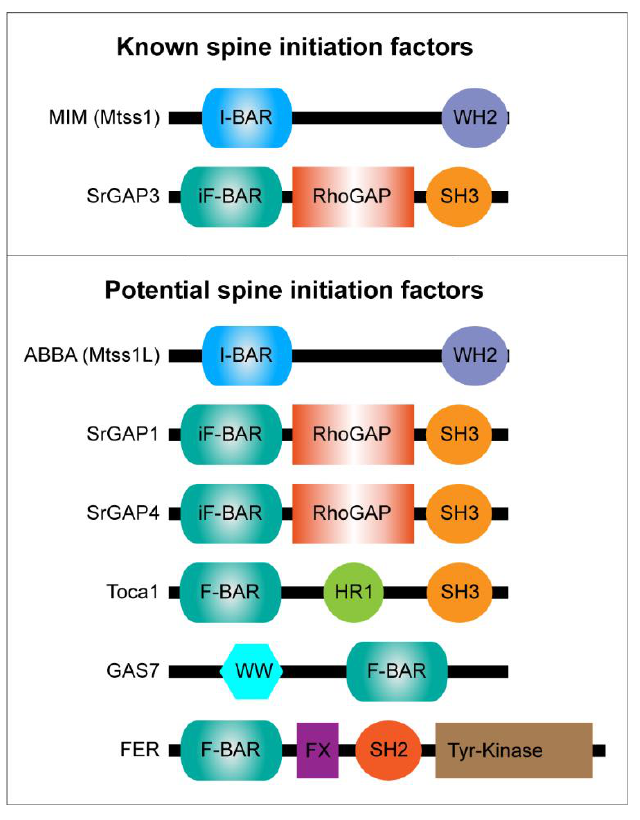
Figure 2. Schematic representation of the domain organization in potential spine initiation BAR- domain proteins . The known spine initiation factors are listed in the upper panel and potential candidates for novel spine initiation factors are listed in the lower panel.